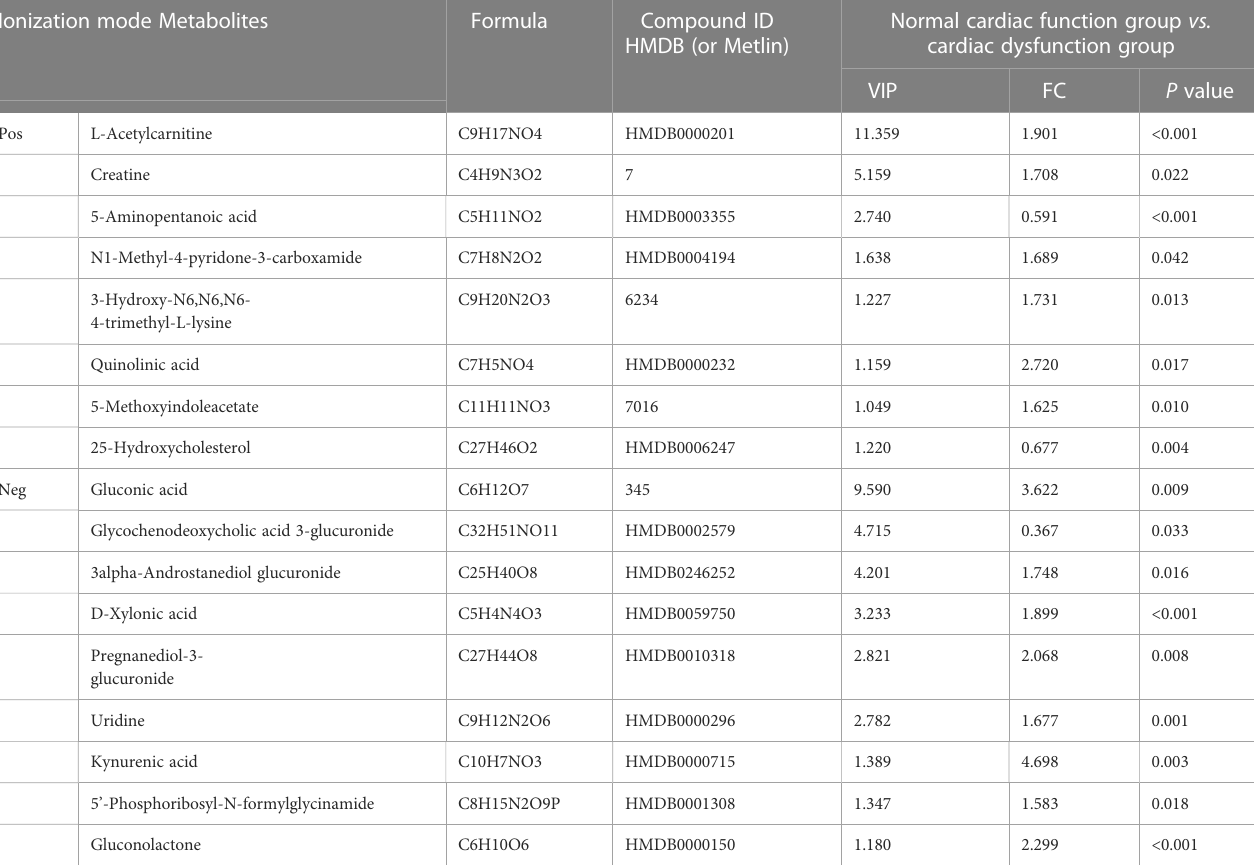
TABLE 2 In two ionization modes, differential metabolites between normal cardiac function group and cardiac dysfunction group.